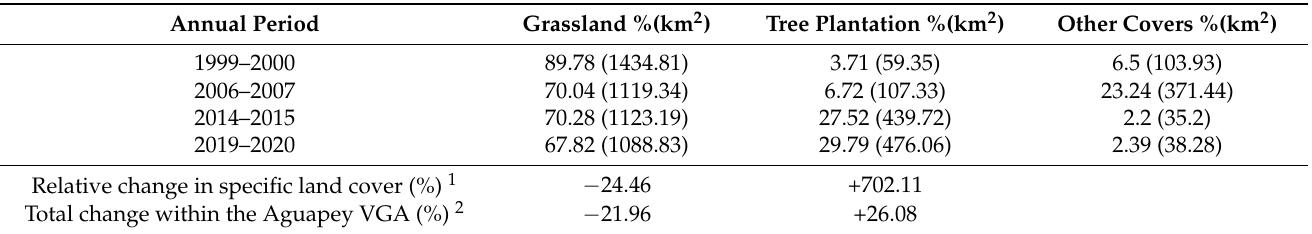
Table 3. Area of each land cover class for the Aguapey VGA in four annual periods based on the unsupervised classification thematic maps.